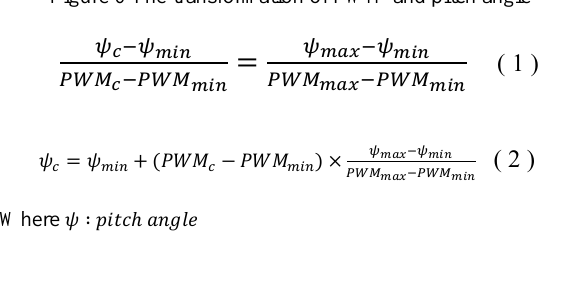
Figure 6 The transformation of PWM and pitch